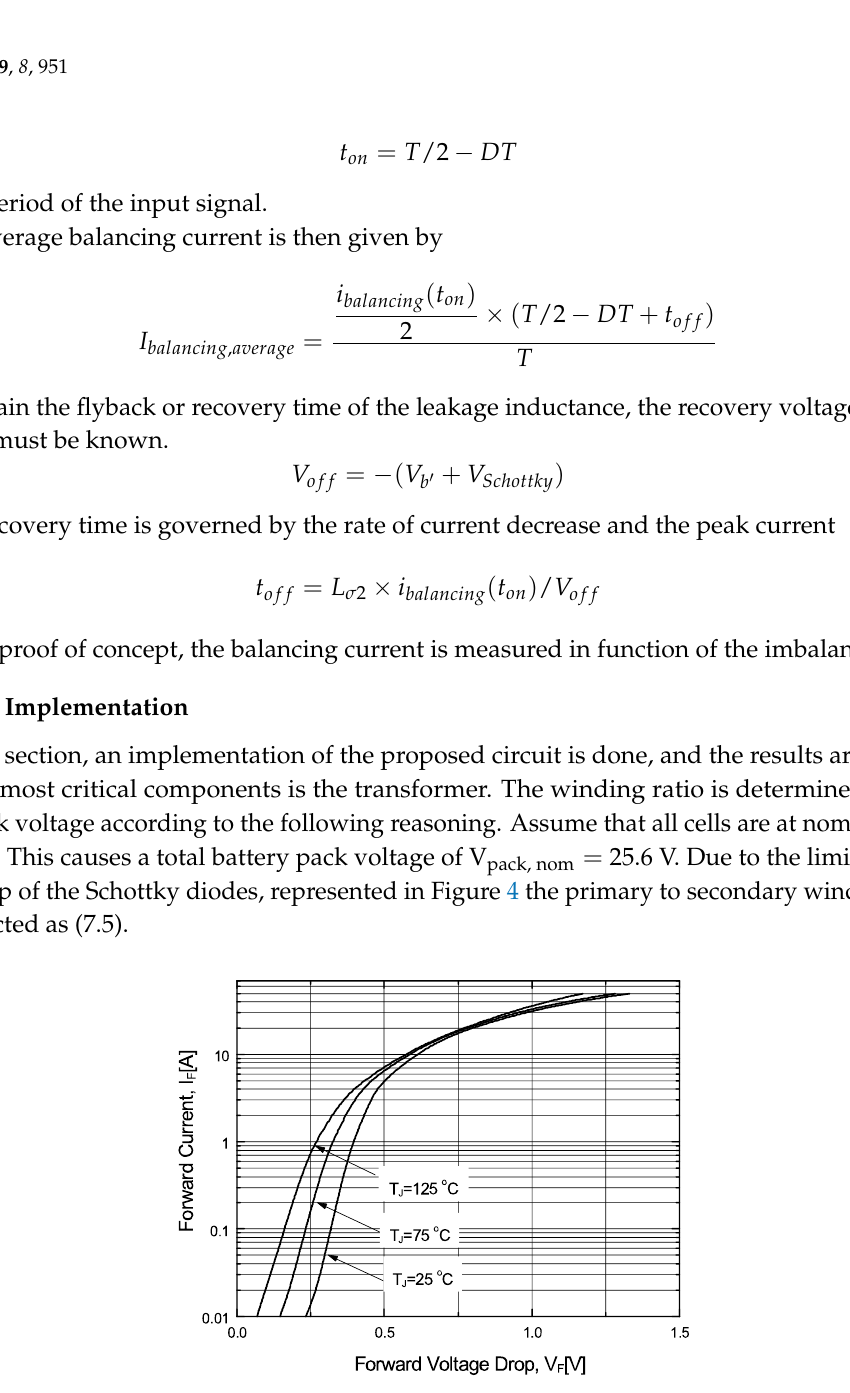
Figure 4. Forward characteristics of Schottky